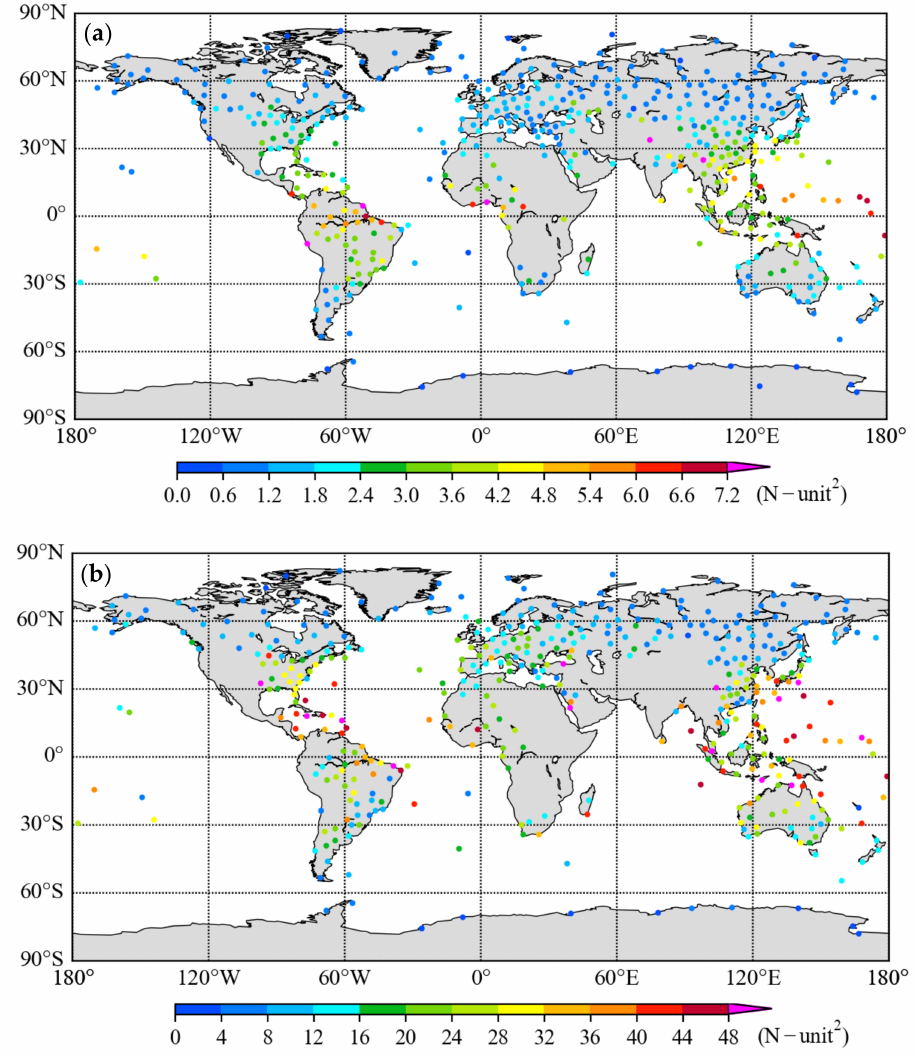
Figure 4. Global distributions of RO refractivity error variances near 521 radiosonde stations at ( a ) 500 hPa and ( b ) 850